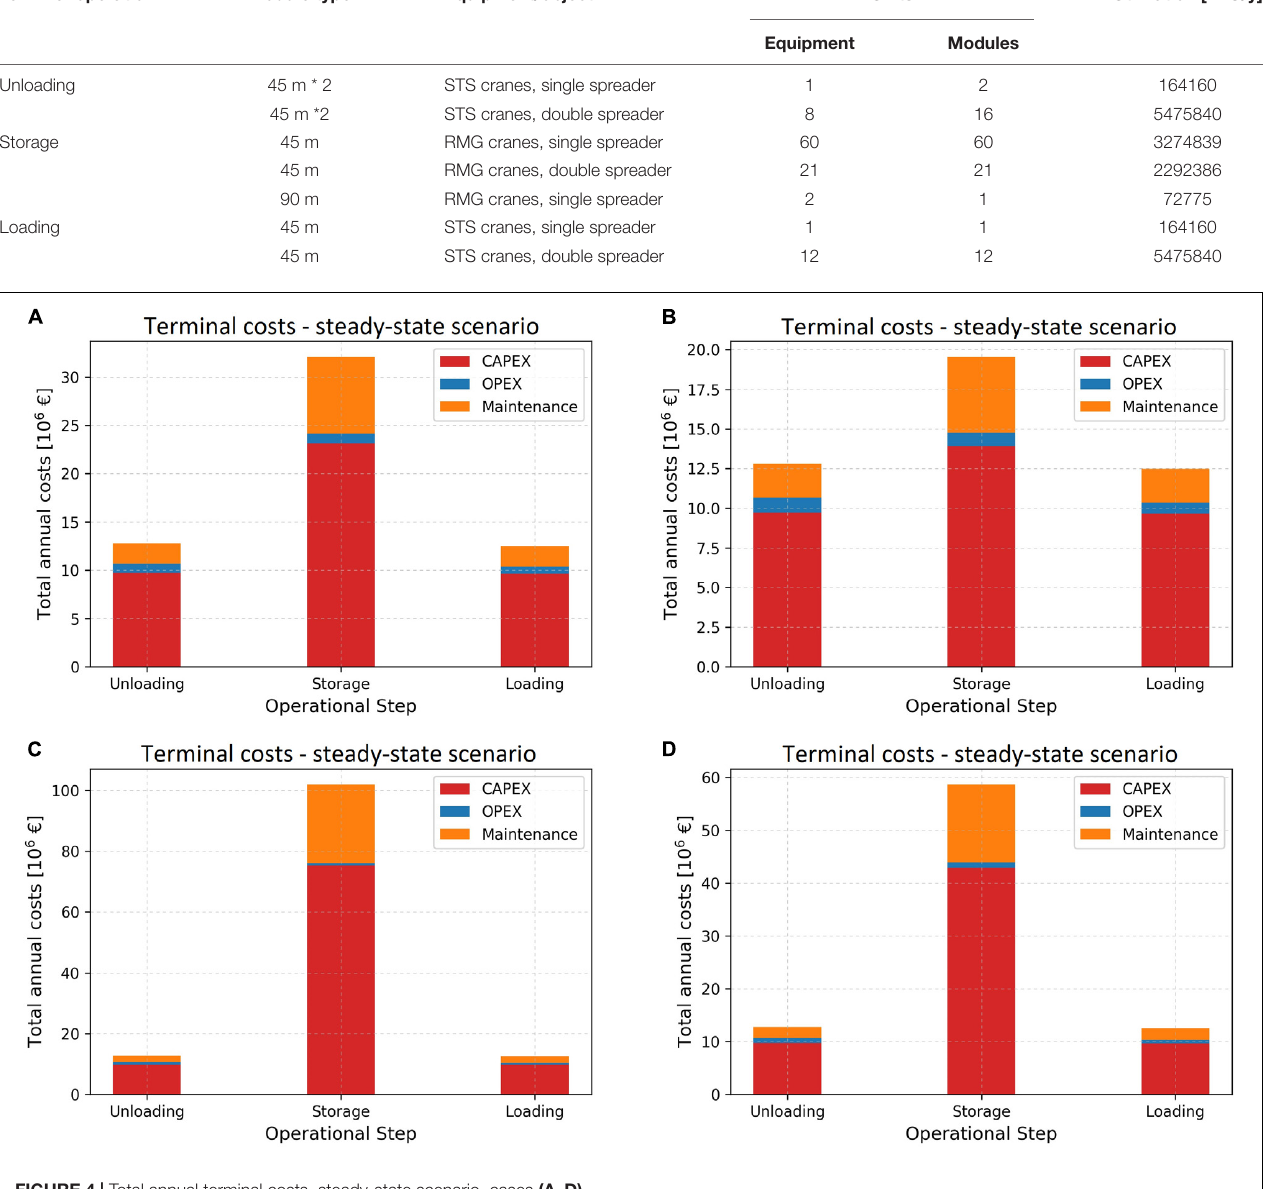
FIGURE 4 | Total annual terminal costs, steady-state scenario, cases (A–D)